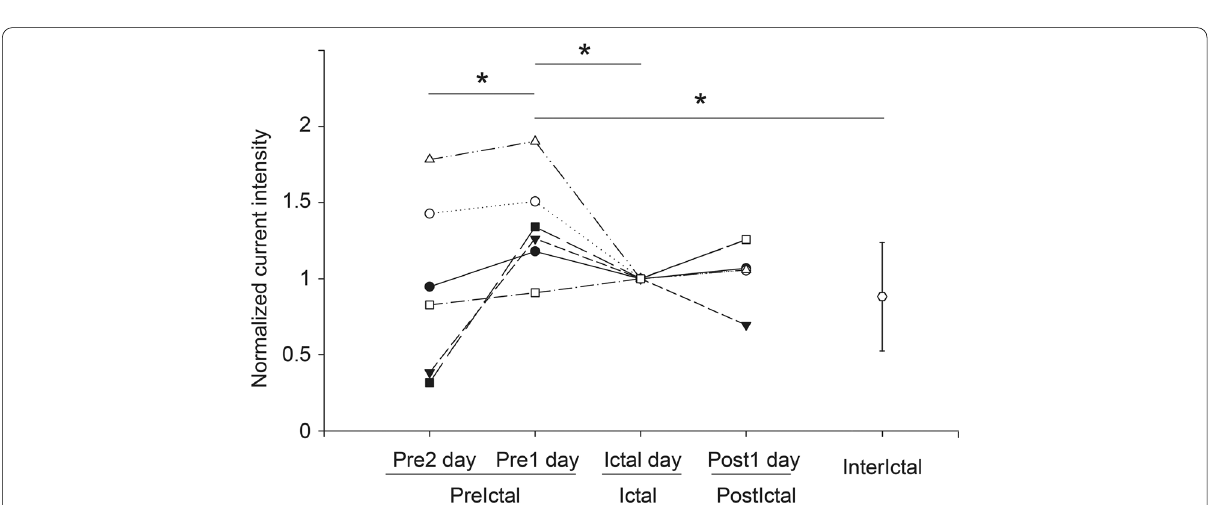
Fig. 6 S1 activation during migraine cycle. Differences in normalised peak S1 intensity among migraine cycles ( n Pre1 , Ictal , Post1, and Interictal ). *, P < 0.05; **, S1, primary somatosensory cortex; Pre2 , 24–48 h before headache onset; Pre1 , within 24 h before headache onset; Ictal , during migraine attack; Post1 , within 24 h after headache offset; Interictal, the period ˃ 48 h between the last and next headache